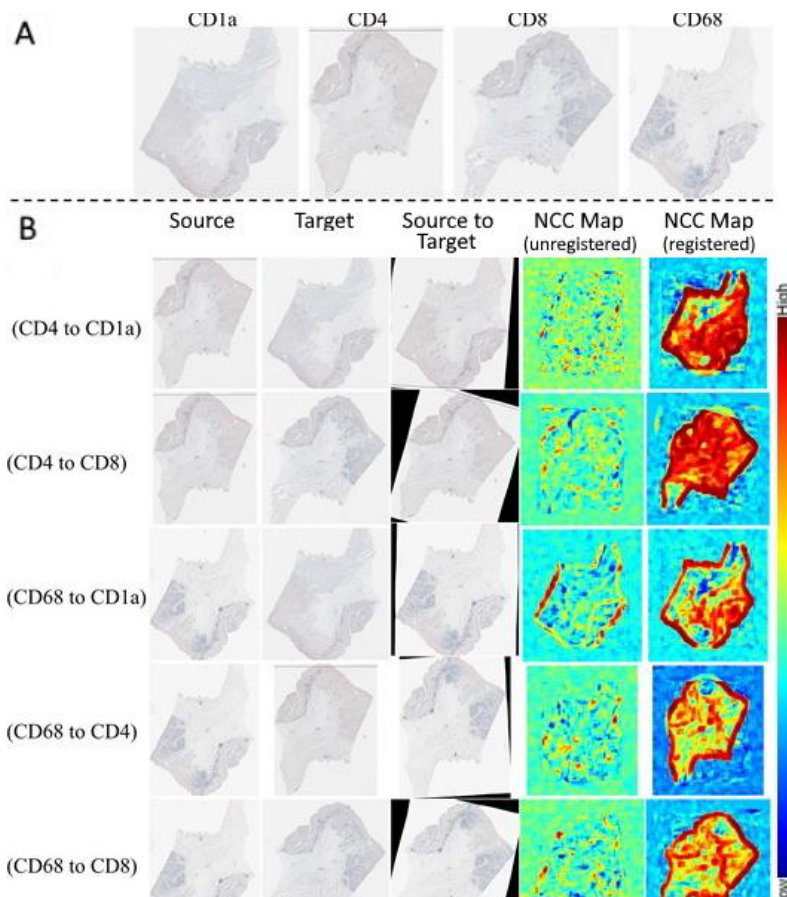
Figure 12. ( A ) Four example consecutive differently stained images from a Gastric mucosa and gastric adenocarcinoma tissue, showing the different stains, namely, CD1A, CD4, CD8, and CD68. ( B ) Example registration results of the source image, registered to the target, resulting in the aligned source. The NCC response maps before and after registration are illustrated in the two right columns.